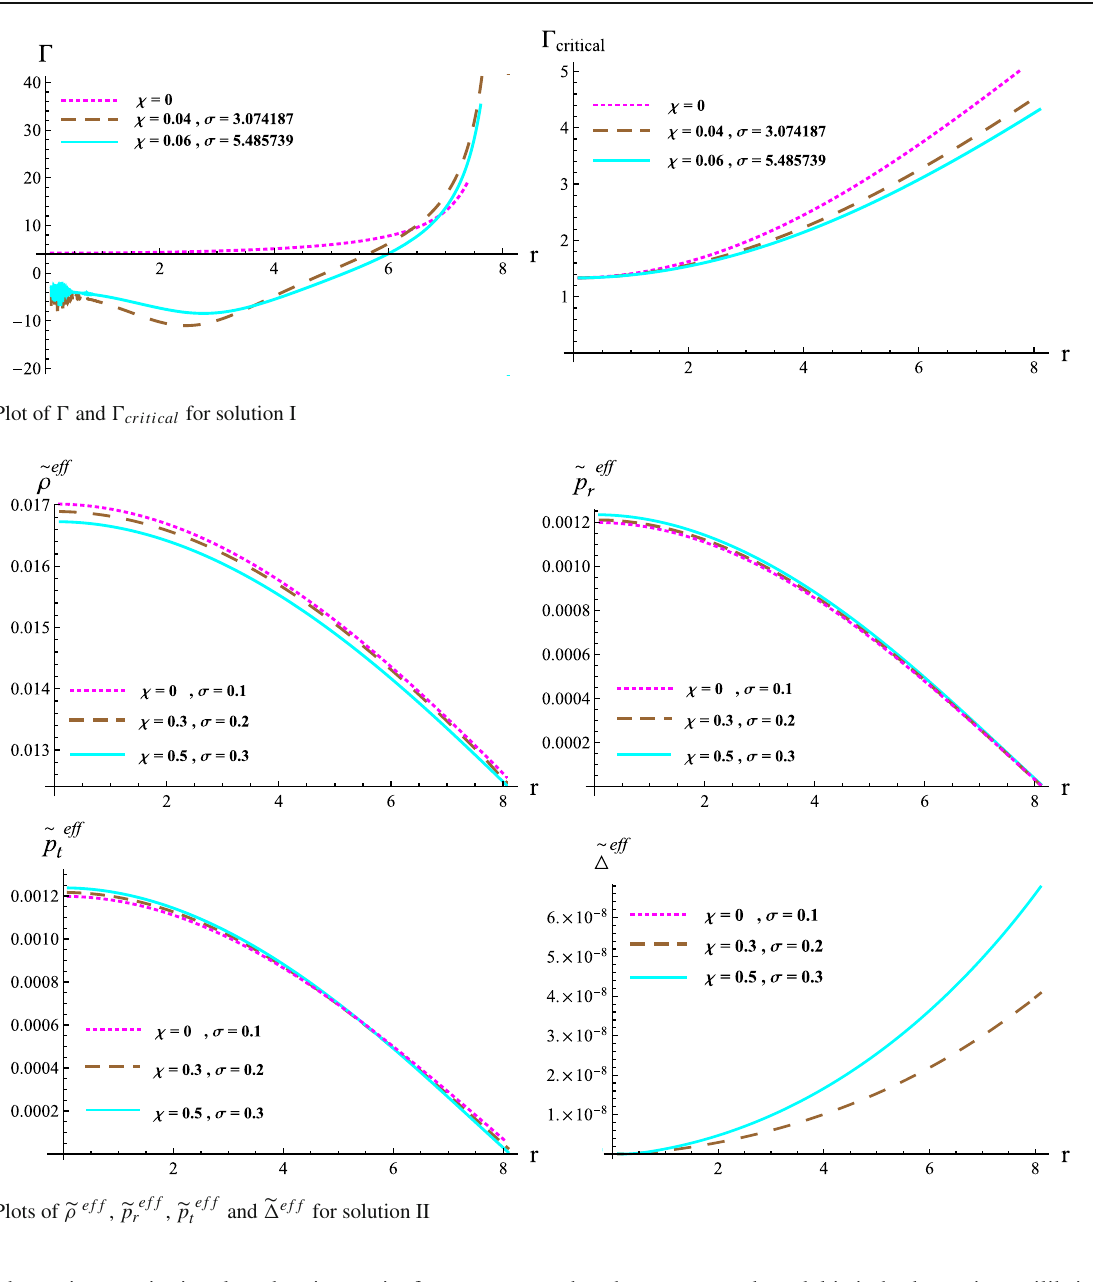
Fig. 6 Plots of (cid:5) ρ ef f , (cid:5) p ef f r , (cid:5) p ef f t and (cid:5) (cid:14) ef f for solution